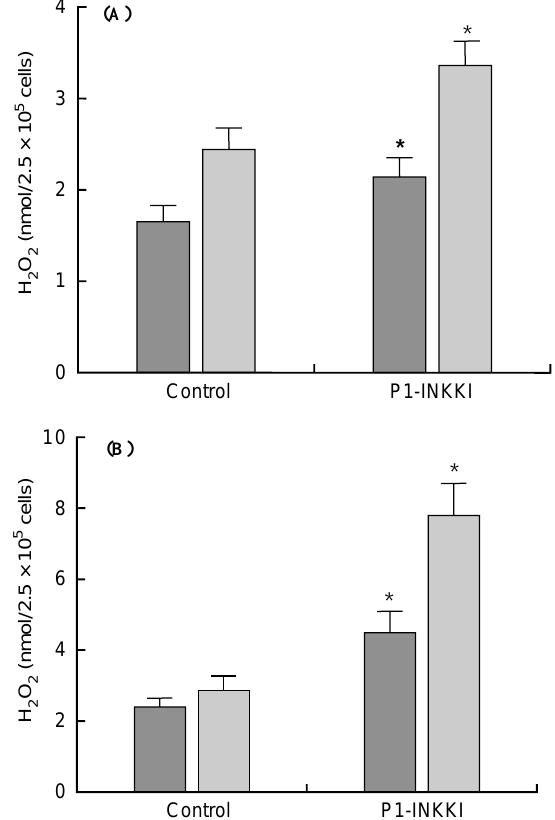
FIG. 5. Effects of the casoparan peptide INKKI, 5 m g (A) and 10 m g (B), on H 2 O 2 production by peritoneal macrophages. The cells were obtained from the peritoneal cavity of mice injected 10 days before the experiments with BCG. H 2 O 2 (nmol H 2 O 2 /2.5 (cid:4) / 10 5 cells/ml) was determined in the absence (dark shading) or in the presence of PMA (light shading). The results are expressed as the mean 9 / standard error of the mean for 8 (cid:2) / 10 animals per group. *p B / 0.05, significantly different in comparison between H 2 O 2 production in the presence of PMA and in the absence of PMA.